Question: Condense the content of this figure into a single sentence.
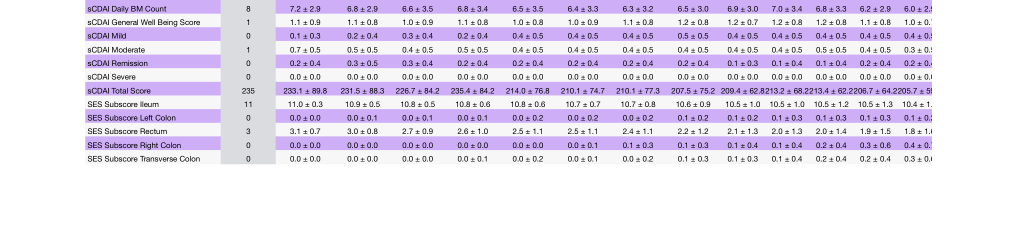
Answer: An example twin record for a single CD patient is shown, which reports the mean and standard deviation of the twins for that patient. A sample of static baseline information is given at the top of the record. A sample of longitudinal outcomes predicted by the model are supplied as rows, with columns indicating the time in months since baseline visit.